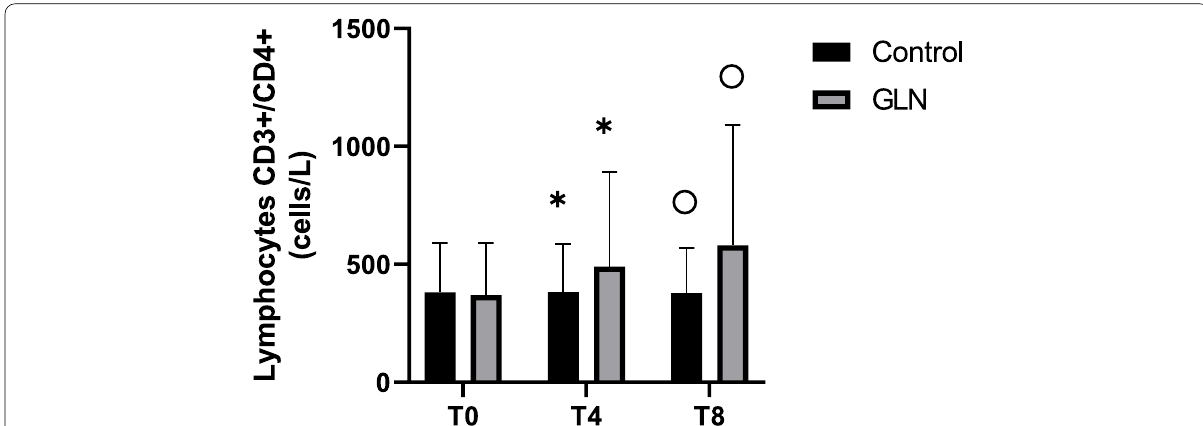
Fig. 2 CD3 /CD4 T helper lymphocyte levels in control and glutamine (GLN) groups. Data are presented as mean + + significant difference in GLN vs control at T4 ( p < 0.01) and T8 ( p < 0.001); ˅ , ”, and • indicate statistically highly significant ( p < 0.001) in the GLN group